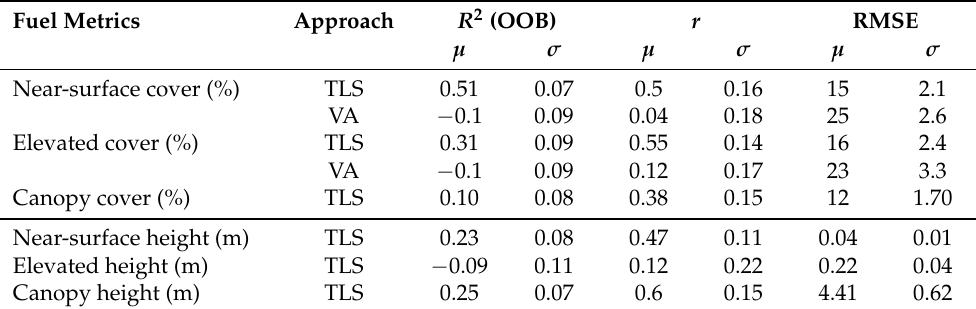
Table 3. Summary results showing mean ( µ ) and standard deviation ( σ ) of out-of-bag score (OOB), Pearson coefficient of correlation ( r ), and RMSE for cover and height estimates from the TLS and visual assessment approaches (VAs). Statistics for visual assessments are available only for near-surface and elevated cover.